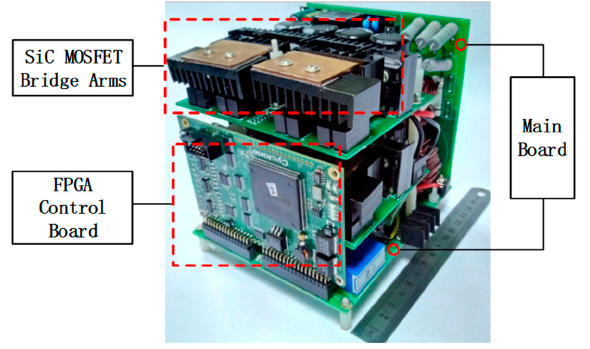
Figure 7. Prototype of the system.